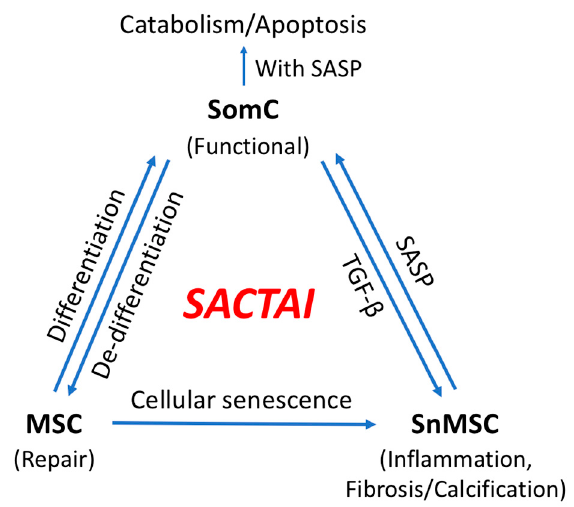
Figure 3. Senescence-associated cell transition and interaction (SACTAI) showing the relationship among SomC, MSC, and SnMSC. Due to aging-induced stress, MSCs proliferate and differentiate while SomCs de-differentiate and result in MSC-like cells for tissue repair. Repeated activation of MSC’s replication induces replicative senescence, resulting in SnMSCs. SnMSCs synthesize pro-inflammatory SASPs, which in turns act on SomCs to trigger catabolism and SomC death. Feedback of SomC with TGF-b reinforces the SnMSC properties including inflammation, fibrosis and abnormal calcification.